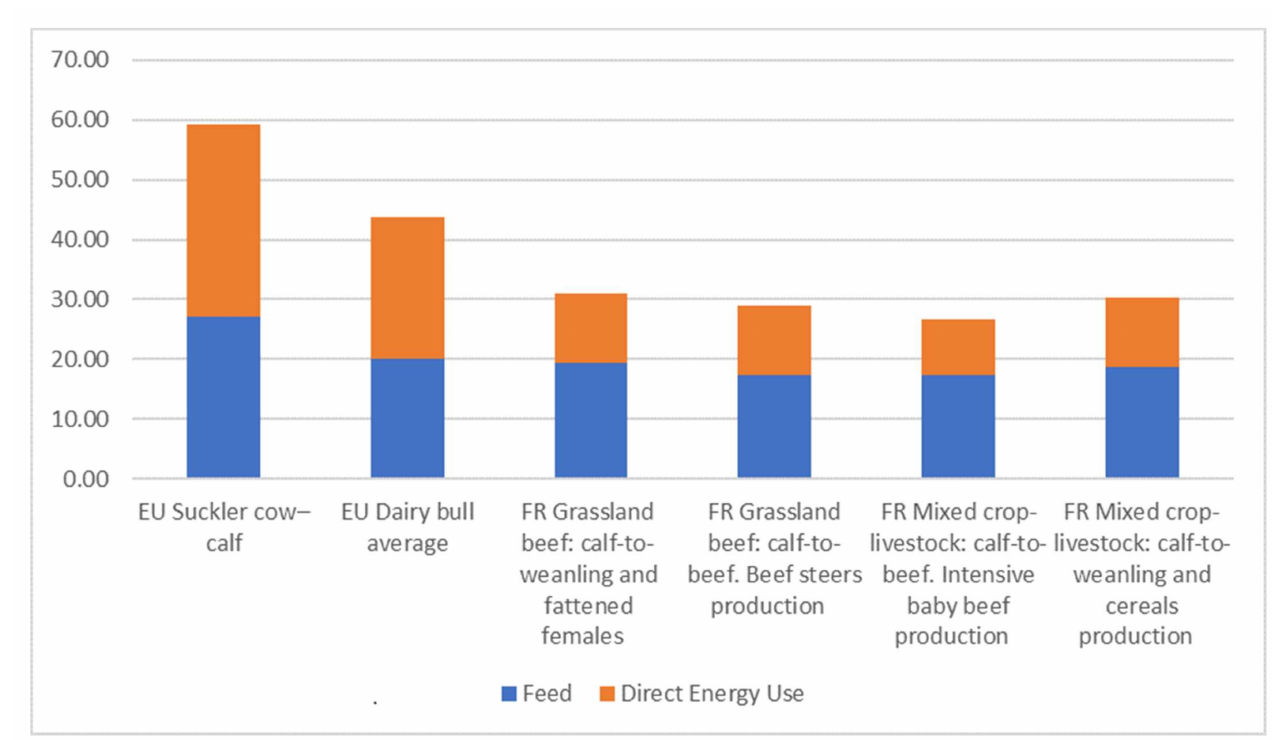
Figure 3. Energy inputs for beef production slaughter weight MJ/kg (based on